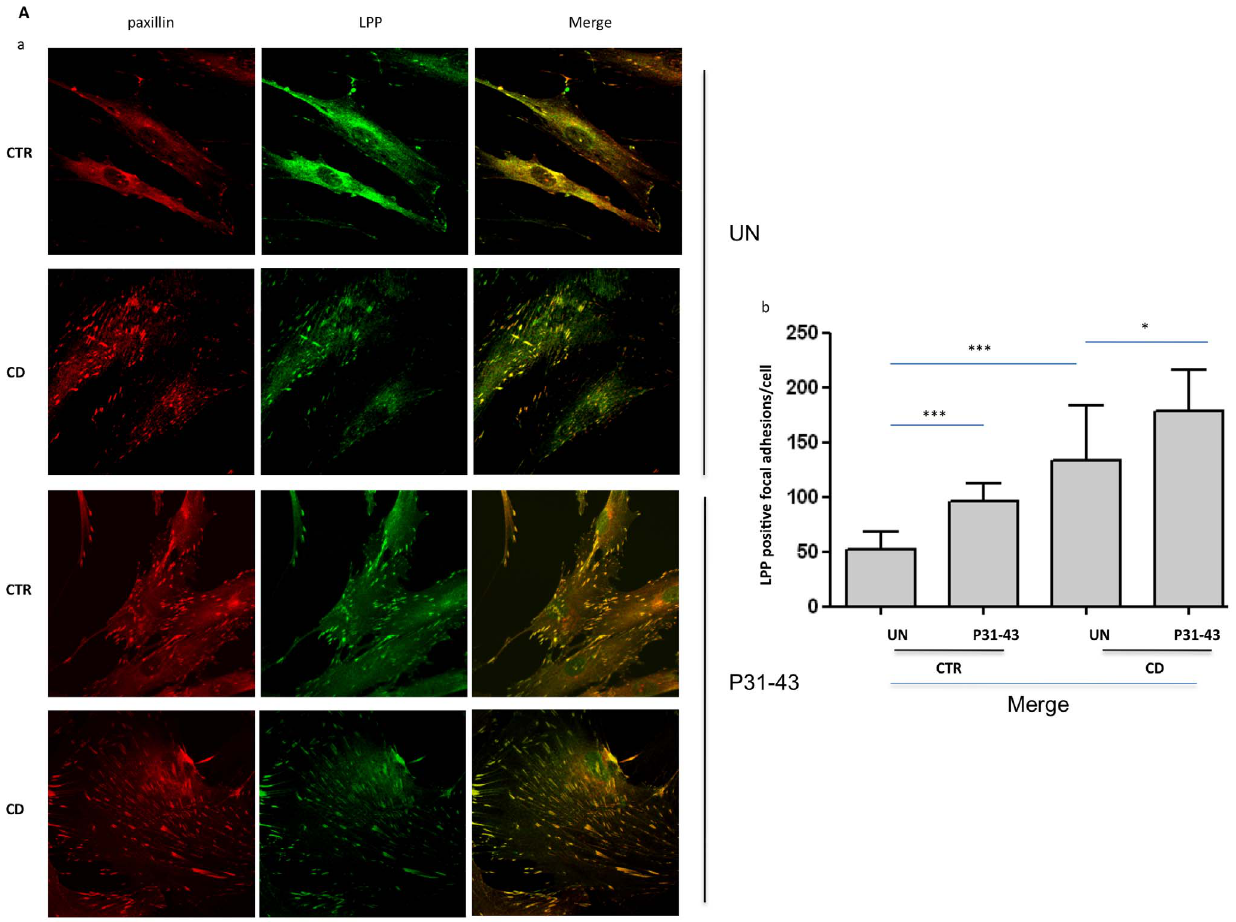
Figure 4. Analysis of LPP levels and sub-cellular distribution in CD and controls fibroblasts before and after P31-43 treatment. A. Increased focal adhesion localization of LPP in CD fibroblasts with respect to controls, as revealed through paxillin co-staining. a) Confocal immunofluorescence images of fibroblasts from CD patients and controls treated or not with P31-43 for 30 min and stained with antibodies against paxillin (red) and LPP (green); the merge of the red and green fields is shown in yellow. Representative fields. b) Statistical analysis of the number of LPP/paxillin-merged positive focal adhesions per cell. Focal adhesions of 30 fibroblasts from several fields from 3 independent experiments with 5 patients and 5 controls were counted. Columns represent the means, and the bars represent the standard deviations. Student’s t -test. *= p , 0.05;***= p , 0.001. B. LPP protein levels were not increased in the fibroblasts from CD patients with respect to the controls and did not vary after 24 h treatment with P31-43. a) Western blot analysis of fibroblasts protein lysates from controls and CD patients treated or not with P31-43. The upper line was stained for LPP, and the lower line was stained for tubulin. Representative experiment. b) Densitometric analysis of western blots stained for LPP in fibroblasts from 5 CD patients and 5 controls treated or not with P31-43. LPP levels were normalized to tubulin levels. Columns represent the means, and the bars represent the standard deviations. Student’s t -test. C. Decreased localization of LPP in the nuclear fraction of CD fibroblasts. a) Western blot analysis of LPP after separating the nuclear and cytosolic protein fractions. The upper lines were stained for LPP, and the lower lines were stained for tubulin and lamin A/C, which were used as loading controls for the cytosol and nuclear fractions, respectively. Representative experiment. b) Densitometric analysis of western blots stained for LPP in fibroblasts from 5 CD patients and 5 controls. The LPP levels were normalized in each protein fractions to the loading controls. Columns represent the means, and the bars represent the standard deviation. Student’s t -test. *=p , 0.05; **= p ,